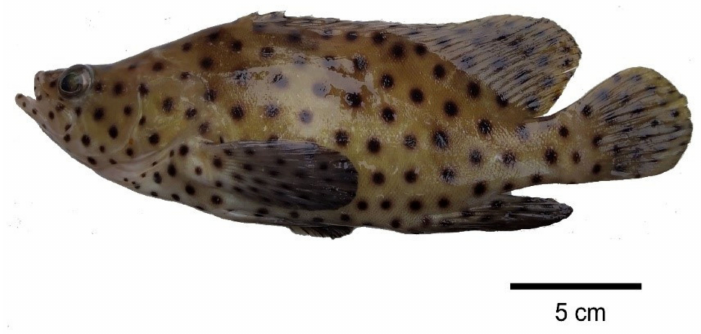
Figure 1. The characteristic of humpback grouper ( Cromileptes altivelis ). Total DNA was extracted from white muscle tissue with a TIANamp Marine Animals DNA Kit (Tiangen Biotech Co., Ltd., Beijing, China). Quality and quantity of total DNA were determined by NanoDrop 2000 (Thermo Fisher Scientific Inc., Waltham, MA, USA). A paired-end sequencing library with insert length of 350 bp was constructed using a TruSeq Nano DNA LT Library Preparation Kit (Illumina, San Diego, CA, USA). The obtained library was then sequenced on Illumina HiSeq X Ten